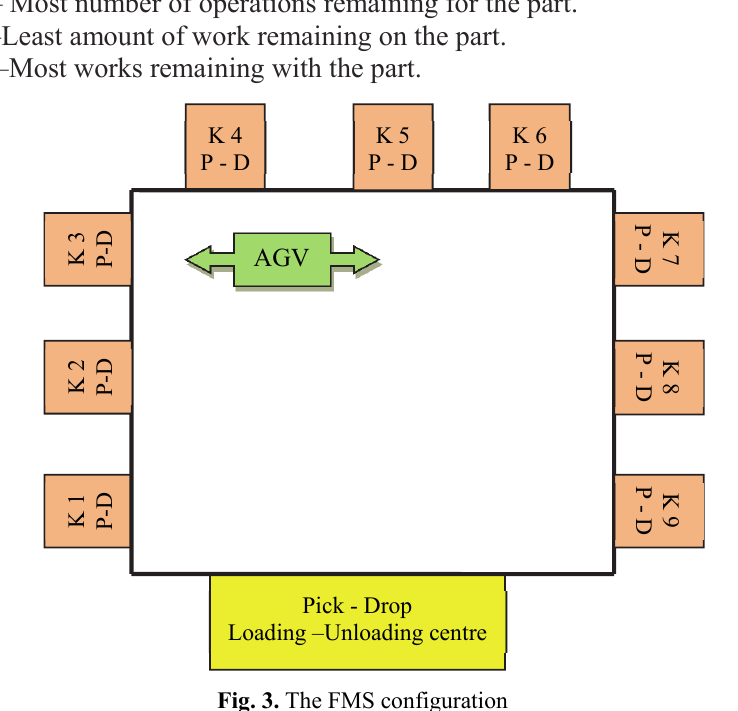
Fig. 3. The FMS configuration